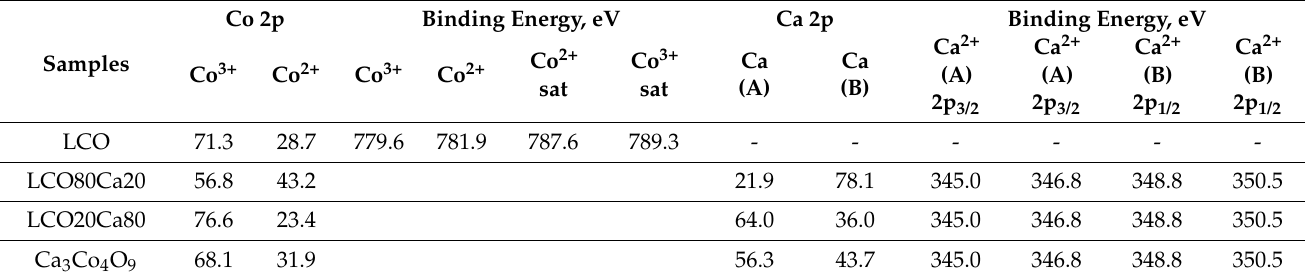
Table 1. Binding energies and relative amount of Co 3+ , Co 2+ , Ca 2+ (A), and Ca 2+ (B) for the perovskite and layered oxides and composites between